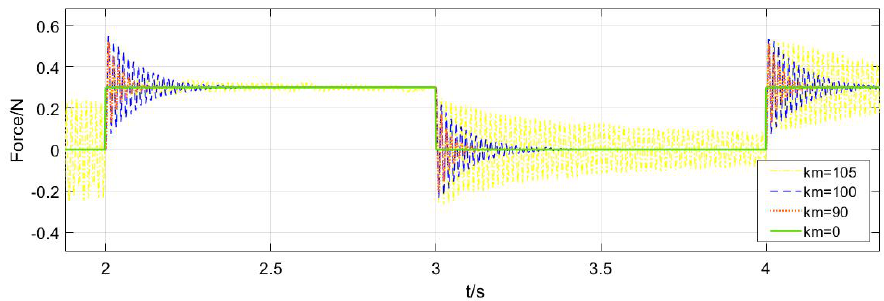
Figure 8. Influence of disturbance feedback coefficient k m on disturbance